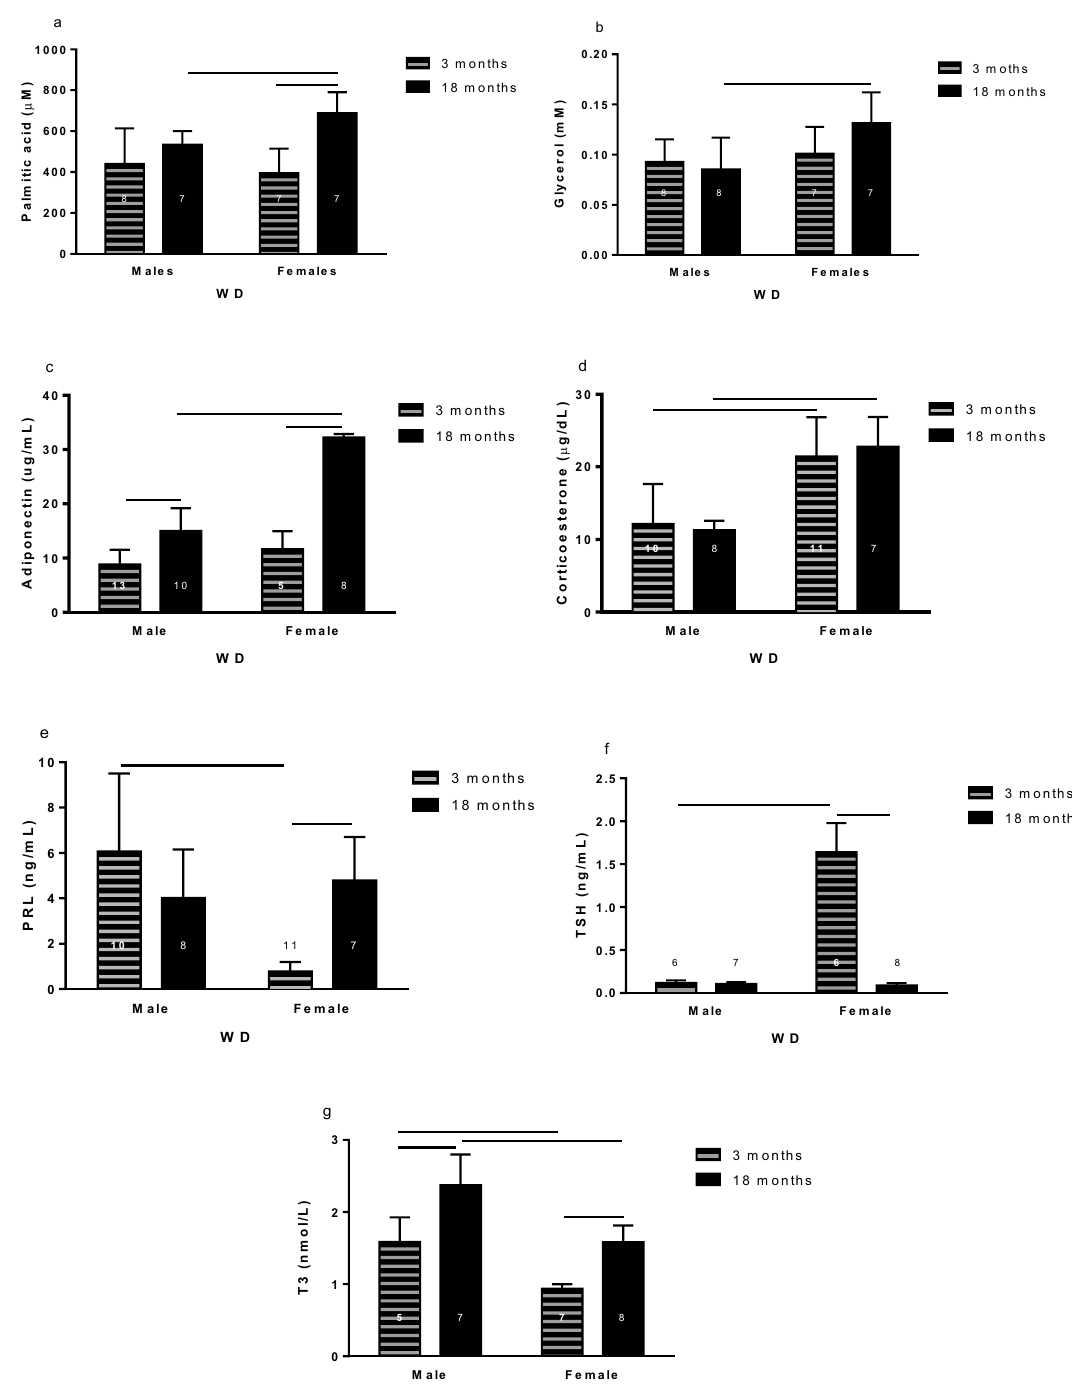
Figure 7. Sex comparation of 3- and 18-month-old rats with water deprivation (WD) of palmitic acid ( a ) and glycerol ( b ), adiponectin ( c ), corticosterone ( d ), prolactin ( e ) thyroid stimulating hormone (TSH) ( f ), and triiodothyronine ( g ) plasma concentration. Data are presented as means (SD), p < 0.05 among the indicated groups. Two-way ANOVA followed by Newman-Keuls post-test when variances were equal, and Games-Howell when variances were different. The n for each group inside or above the